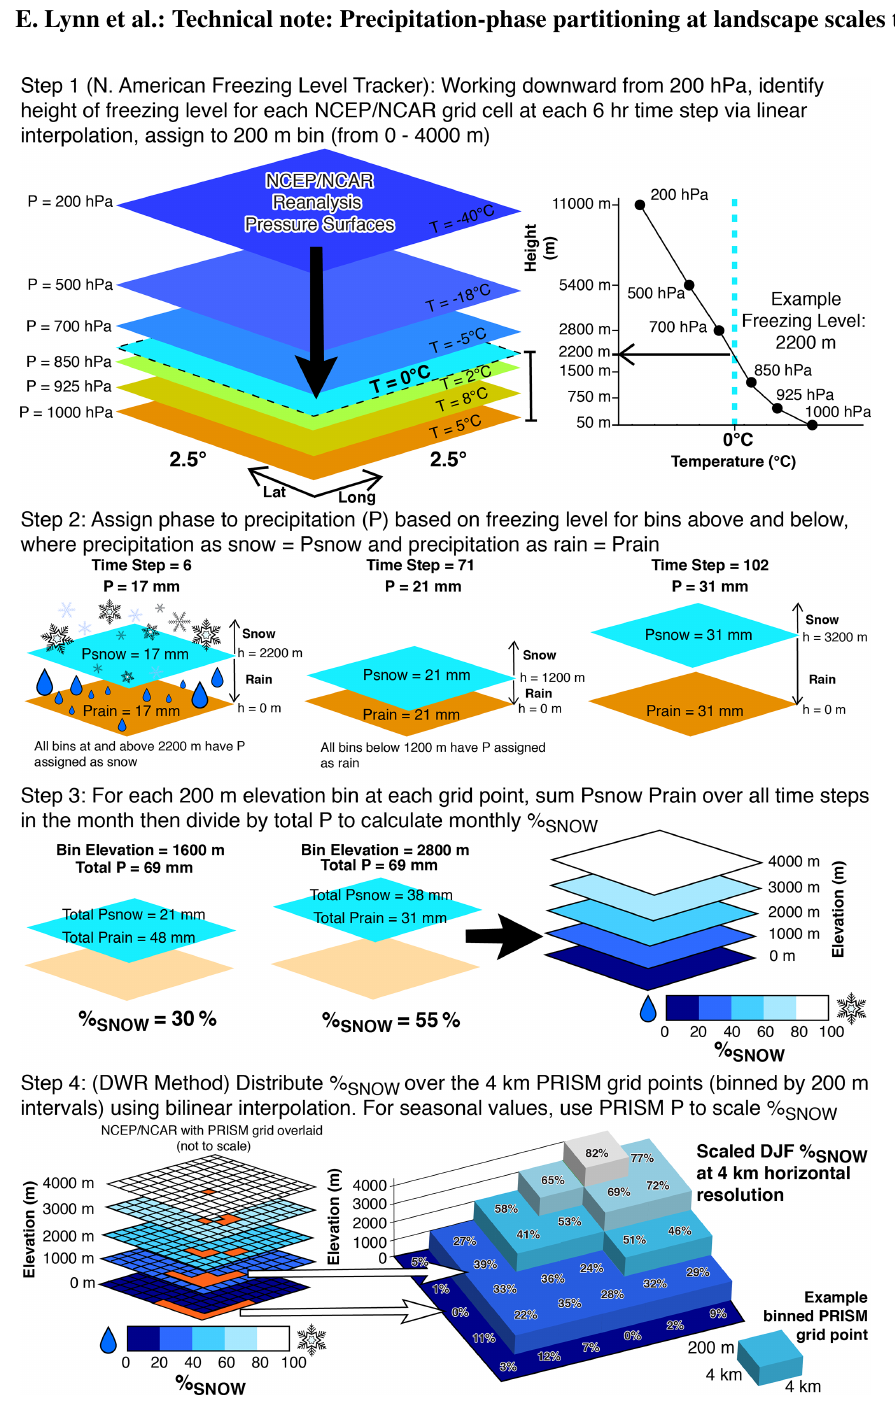
Figure 2. Conceptual diagram illustrating the four key steps in the calculation of % SNOW at a 4km horizontal resolution, using 200m elevation bins, starting with a 2 . 5 ◦ × 2 . 5 ◦ horizontal resolution NCEP/NCAR